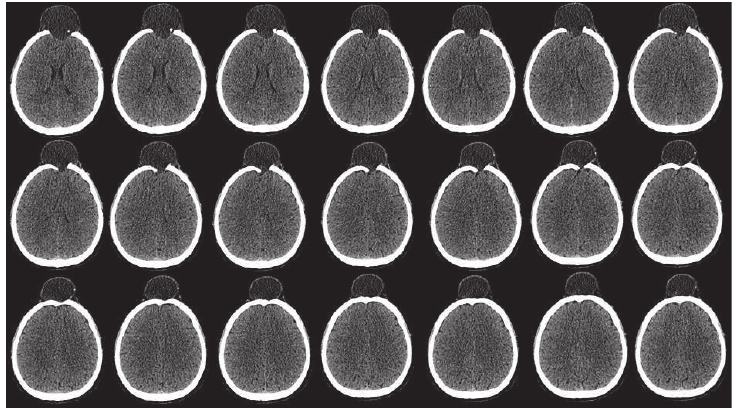
Figure 5. CT scan images of patient.